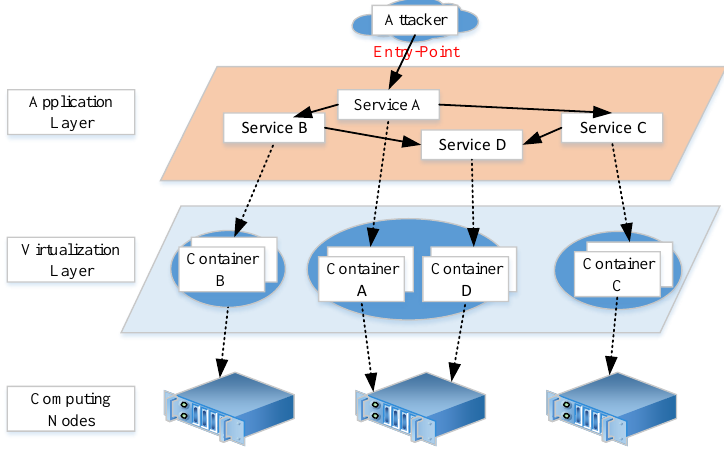
Figure 1. The architecture of a container-based cloud.